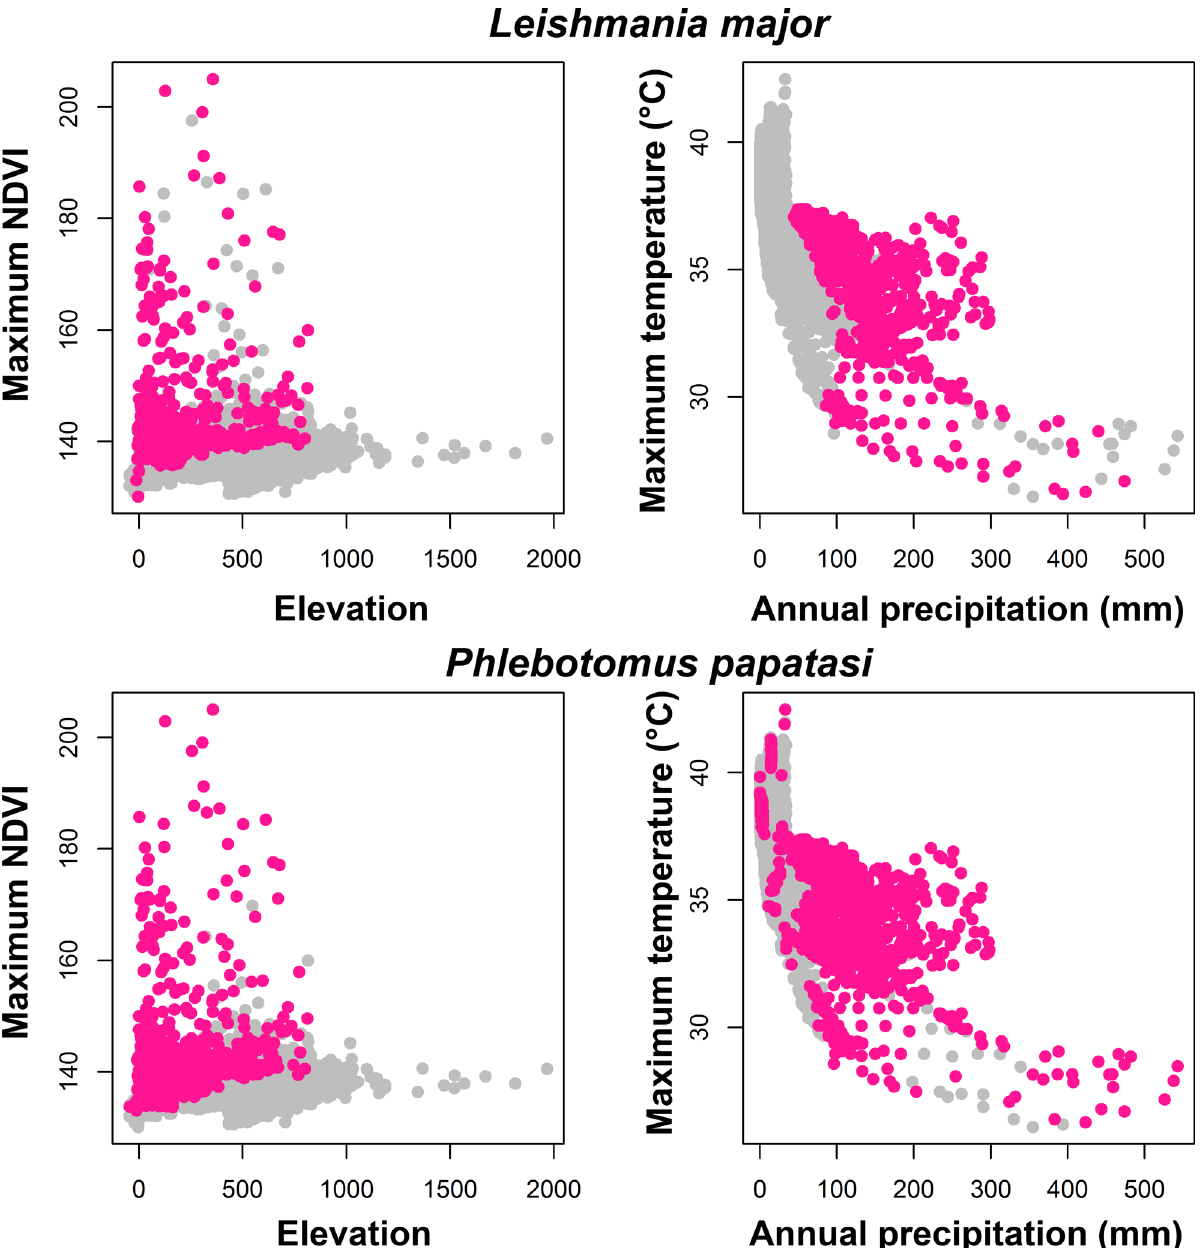
Fig 3. Visualization of Leishmania major , and Phlebotomus papatasi ecological niches in example dimensions. Overall set of environments available across Libya in gray; modeled suitable conditions for the species occurrences in pink. Similar visualizations of ecological niches for the potential mammal reservoir species are in the Supporting Information (S4